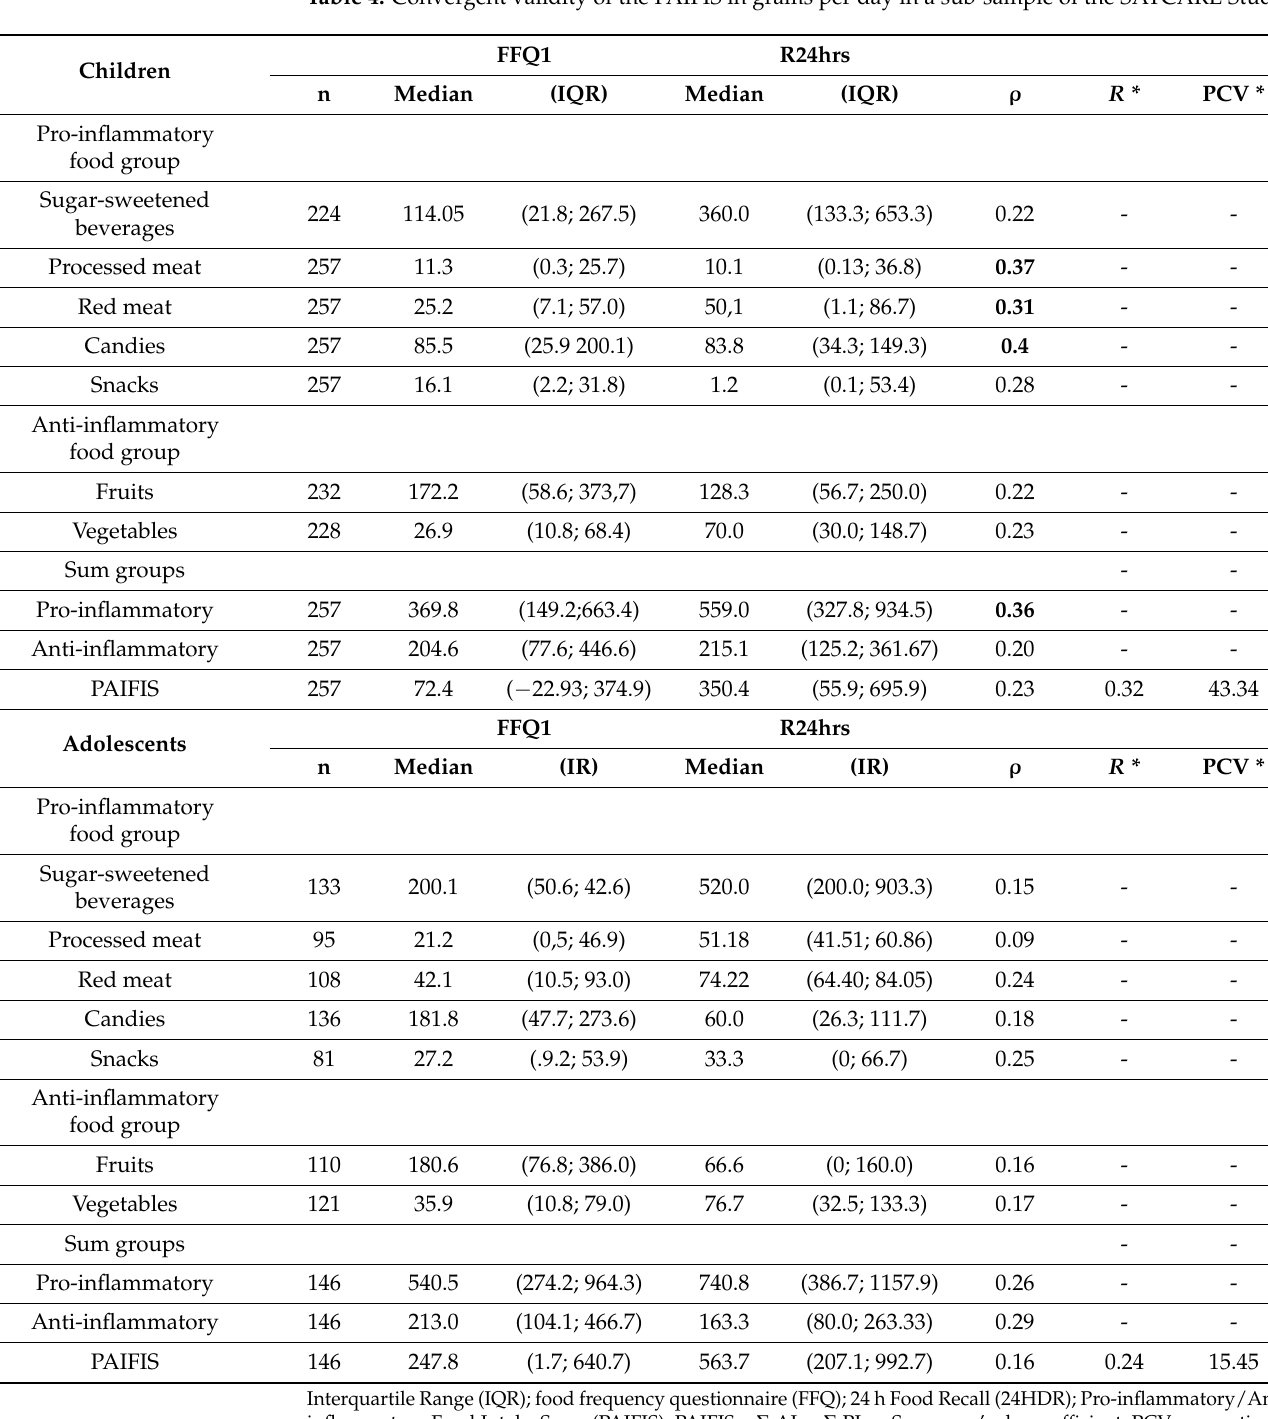
Table 4. Convergent validity of the PAIFIS in grams per day in a sub-sample of the SAYCARE